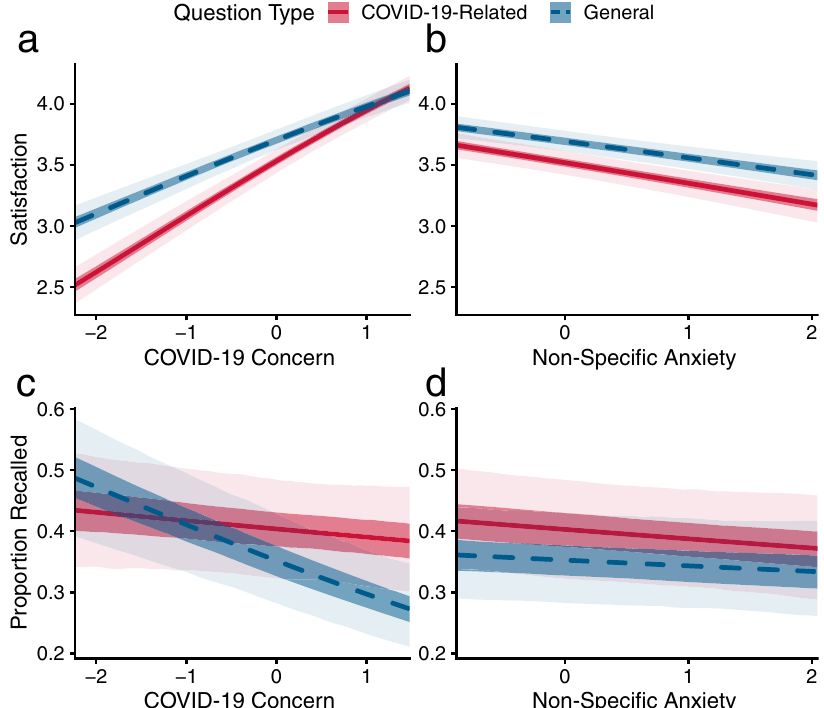
Fig. 3 Motivation correlated with subsequent satisfaction with answers to questions and subsequent memory for the answers. a Greater COVID-19 concern is associated with more self-reported satisfaction, especially for COVID-19-related questions. b In contrast, non-speci fi c anxiety is associated with a reduction in satisfaction for both question types. c COVID-19 concern is associated with poorer memory for general information, while information related to COVID-19 is spared. d Non-speci fi c anxiety is not signi fi cantly associated with memory. Lines denote mean posterior prediction from multilevel regression models, dark shaded areas mark 50% PIs, and light areas 95% PIs. Source data are provided as Source Data fi les.